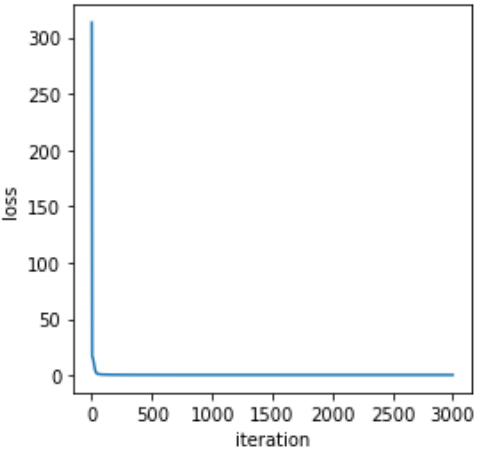
Figure 12. Iteration curve during the